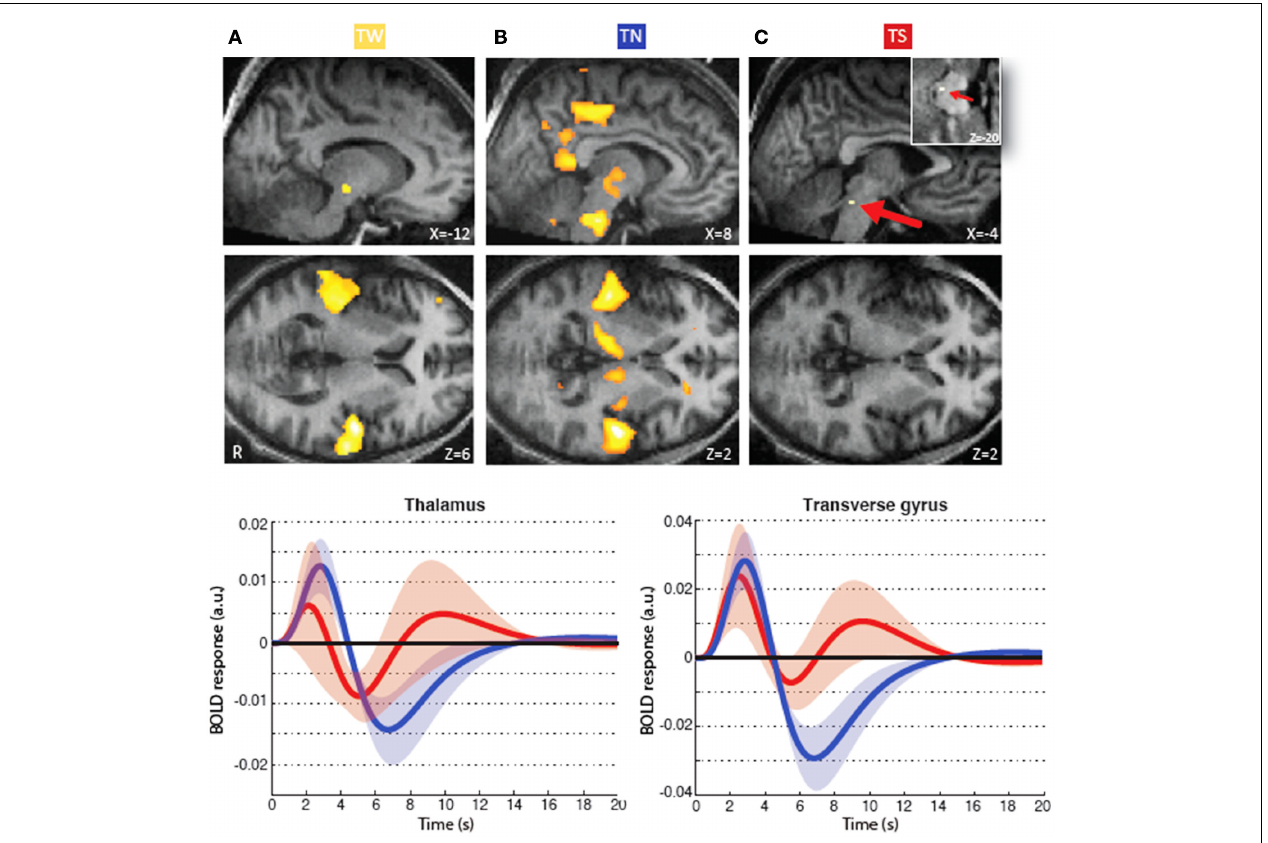
the cochlear nuclear groups the trapezoid bodies and the superior olivary complex. (C) Significant responses associated with tones presented within spindles in stage 2–3 sleep (TS). Here neural populations that process sound are found in the nuclei of the lateral lemniscus of the brainstem (insert, marked by arrow). Lower panels depict the fitted responses in the thalamus [ x =− 12, y =− 22, z =− 6; left panel] and the auditory cortex [ x = 58, y =− 14, z = 6; right panel] associated with sounds delivered with (red) or without (blue) ongoing spontaneous spindles.The curves correspond to the mean and the shaded areas to the SEM. Functional results are displayed on an individual structural image (displayed at p < 0.001, uncorrected). (Modified from Dang-Vu et al., 2011. Copyright by the National Academy of